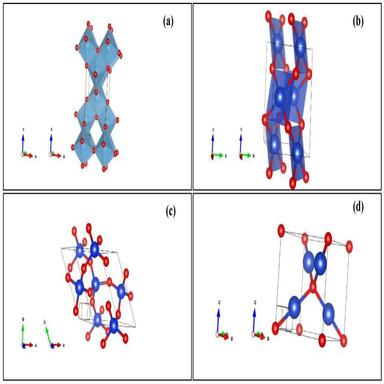
3D structure: (a) anatase (tetragonal); (b) tenorite (monoclinic); (c) α-quartz (trigonal); (d) Cuprite (cubic). Source: Drawn in VESTA 3 using AMC data from American Mineralogist Crystal Structure Database-Rruff ((http://rruff.geo.arizona.edu/AMS/amcsd.php) (http://rruff.geo.arizona.edu/AMS/amcsd.php))